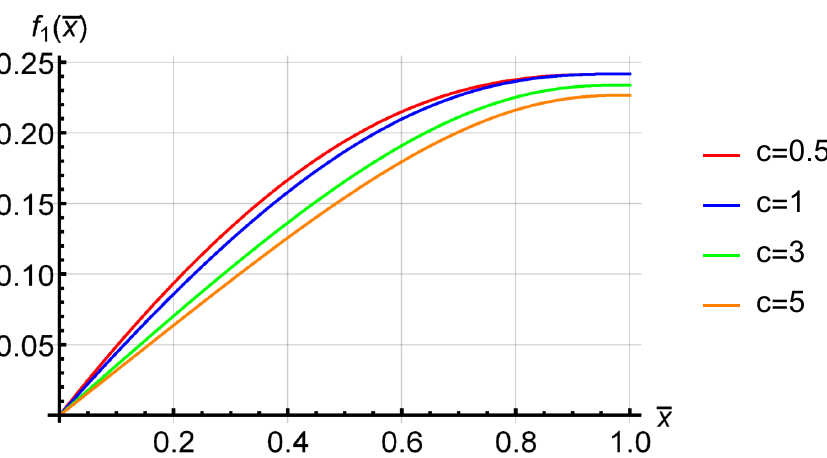
Figure 7. Parametric plot of f 1 ( ¯ x ) considering the first flexural mode and several tapering ratios c .